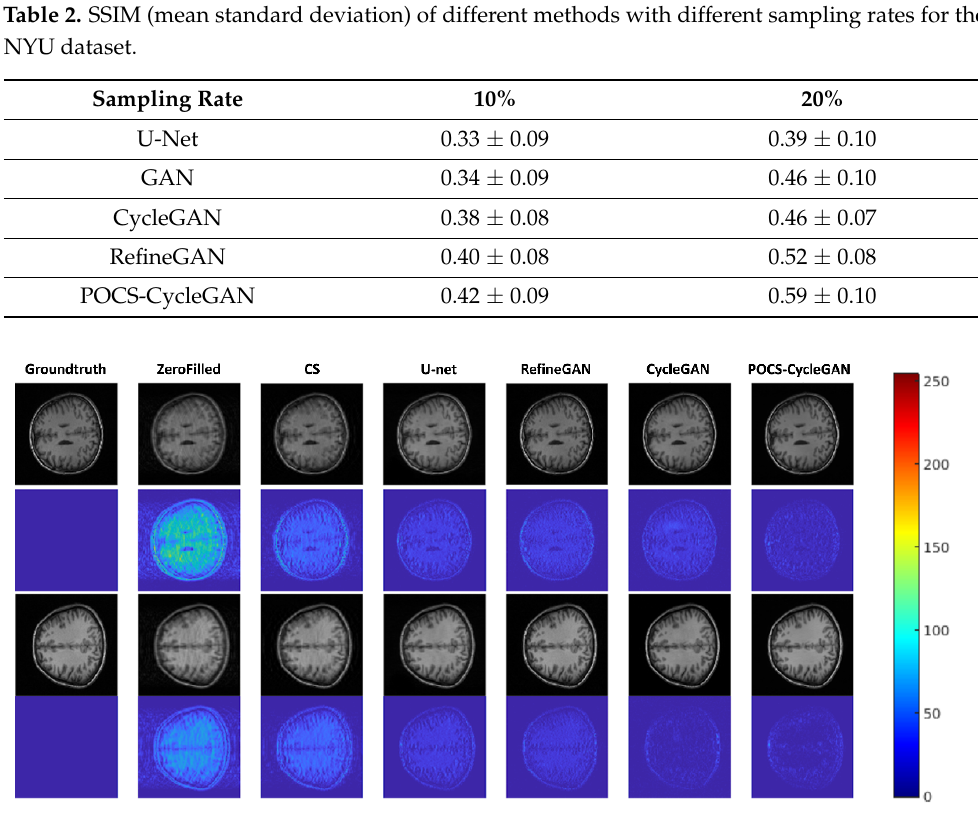
Figure 6. The fully sampled and undersampled brain images. The first and third rows are the brain images, and the second and fourth rows are the difference between the reconstructed image and the ground truth. The methods used for reconstructing the images are provided on top of each column. The undersampling rate was 20%, with a pseudo-random Cartesian sampling trajectory. The color bar is set between [0, 255].